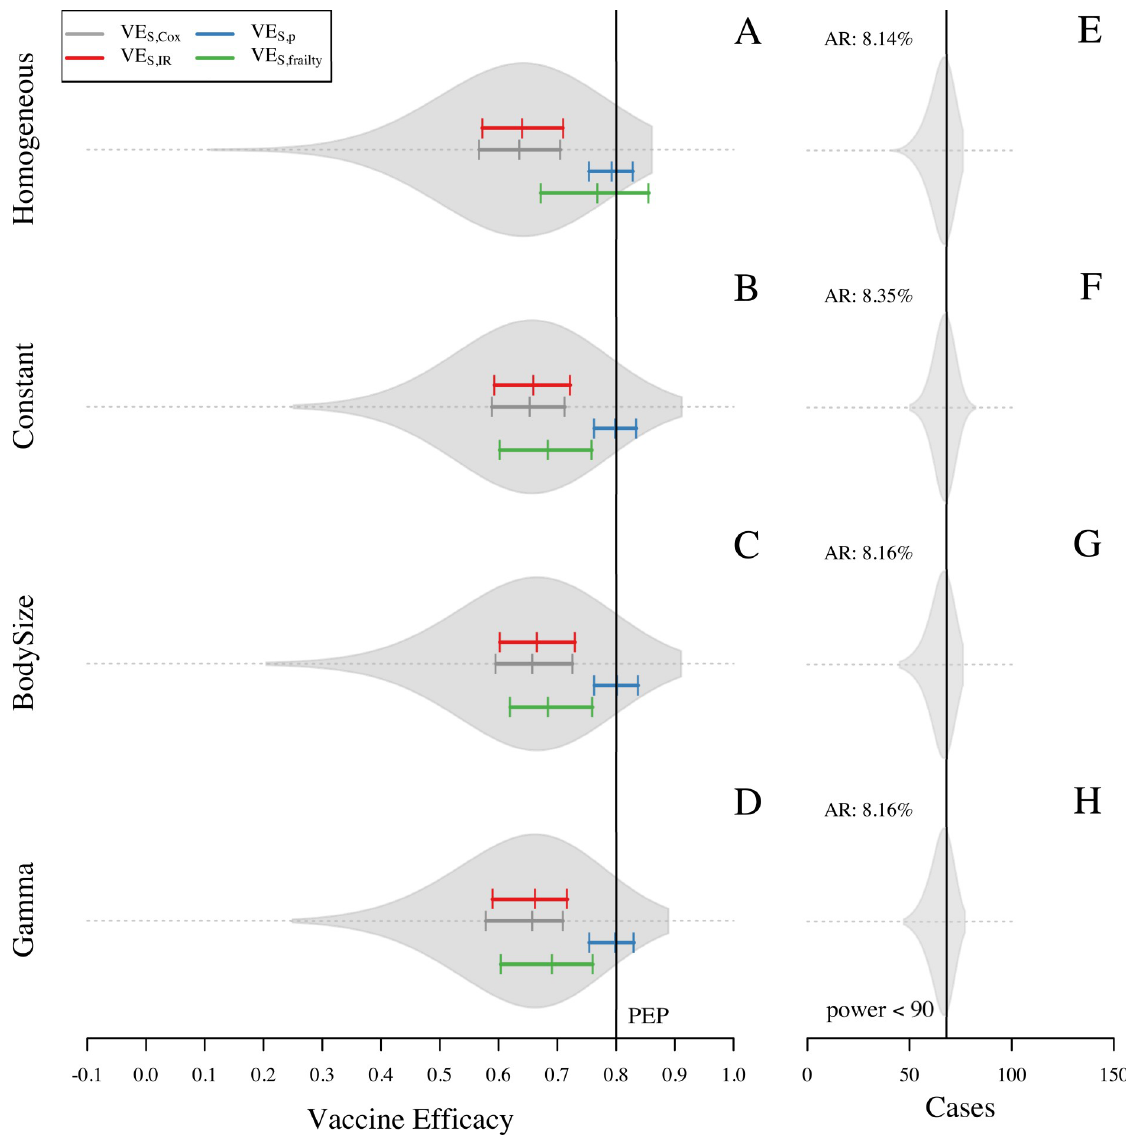
Fig 7. Overall VE S estimates from 1,000 simulations of each setting with different assumptions about heterogeneous exposure in a high-intensity setting. Sample size was adjusted to 800 participants to achieve 90% statistical power in a higher transmission setting. Each row represents an assumption about heterogeneous exposure to DENV: homogeneous hazard of exposure, constant attractiveness of humans, attractiveness of humans based on body size, and attractiveness of humans based on a gamma distribution (shape = 1.43 and scale = 1). VE S is calculated with four different methods: VE S,Cox , VE S,IR , VE S,CI , and VE S,p . Violin plots on the left panel show the shape of the distribution of VE S,Cox estimates. Colored solid lines show the 25, 50, and 75 quantiles for VE S,Cox , VE S,p , VE S,IR , and VE S,frailty (gray, blue, red, and green, respectively). Black solid line represents the true PEP = 1—RR inf|exp RR dis|inf = 0.8. Right panel corresponds to the number of cases captured in the